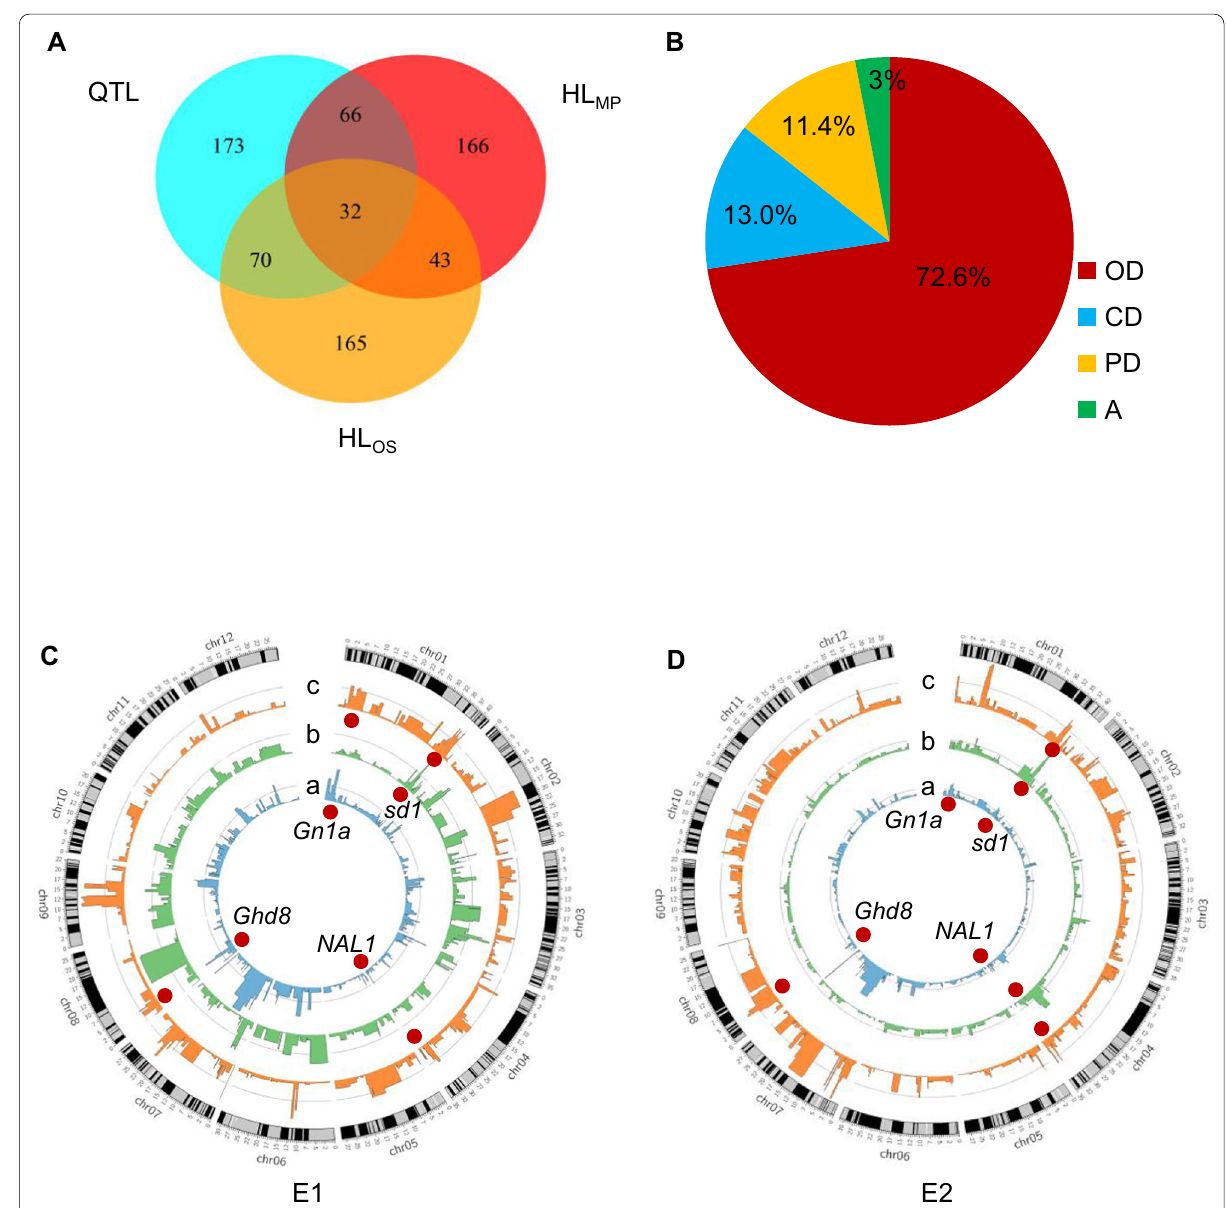
Fig. 3 QTLs and heterotic loci for mid-parent heterosis (MPH) and over-standard heterosis (OSH) detected in the CSSLs, BC, and TC populations. a The quantitative trait loci (QTLs) and HLs were co-localized in the same or overlapping regions among the three populations. b The proportions of the different genetic effects at mid-parent heterotic loci (HL MP ). OD, overdominance; CD, complete dominance; PD, partial dominance; A, additive. c , d Genome-wide distribution of QTLs, HL MP and over-standard heterotic loci (HL OS ) for spikelet number (SN) in 2006 (E1) and 2007 (E2). Rice chromosomes with bins are indicated in the outer circle. The circles from inward to outward show QTLs ( a ), HL OS ( b ), and HL MP ( c ), respectively. For each bar diagram, the x -axis represents the physical location along each numbered chromosome. The y -axis represents the P value for single nucleotide polymorphism (SNP) association. Dashed lines indicate the declaration thresholds. Some major heterosis-related genes reported in previous studies are indicated by red dots in c ,